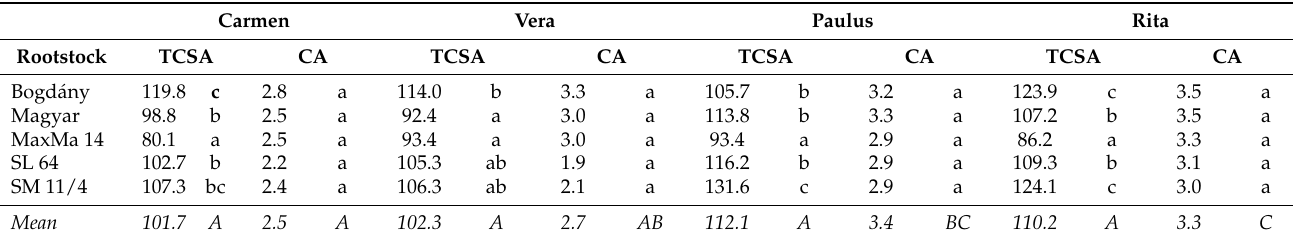
Table 2. Growth parameters of trees TCSA (cm 2 ) in 2020 and canopy area CA (m 2 ) in